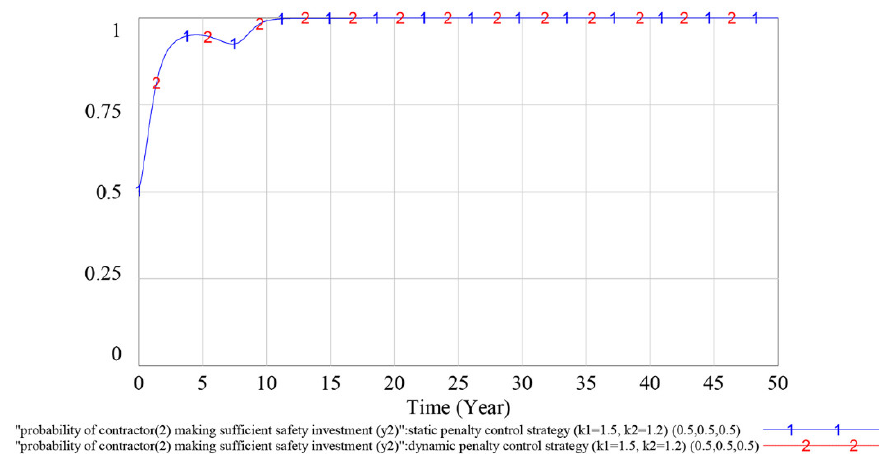
Figure 9. Influence of different penalty control strategies on contractor (2)’s strategy choices.